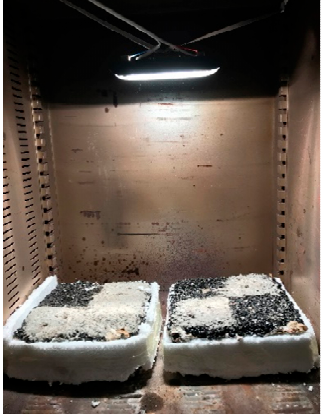
Figure 2. Cooling test site.